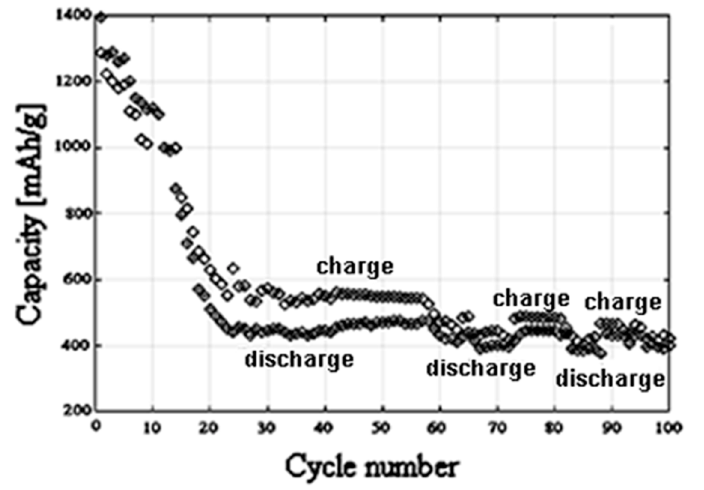
Figure 14. Capacity trend as a function of cycle number for core–shell S–TiO 2 materials.